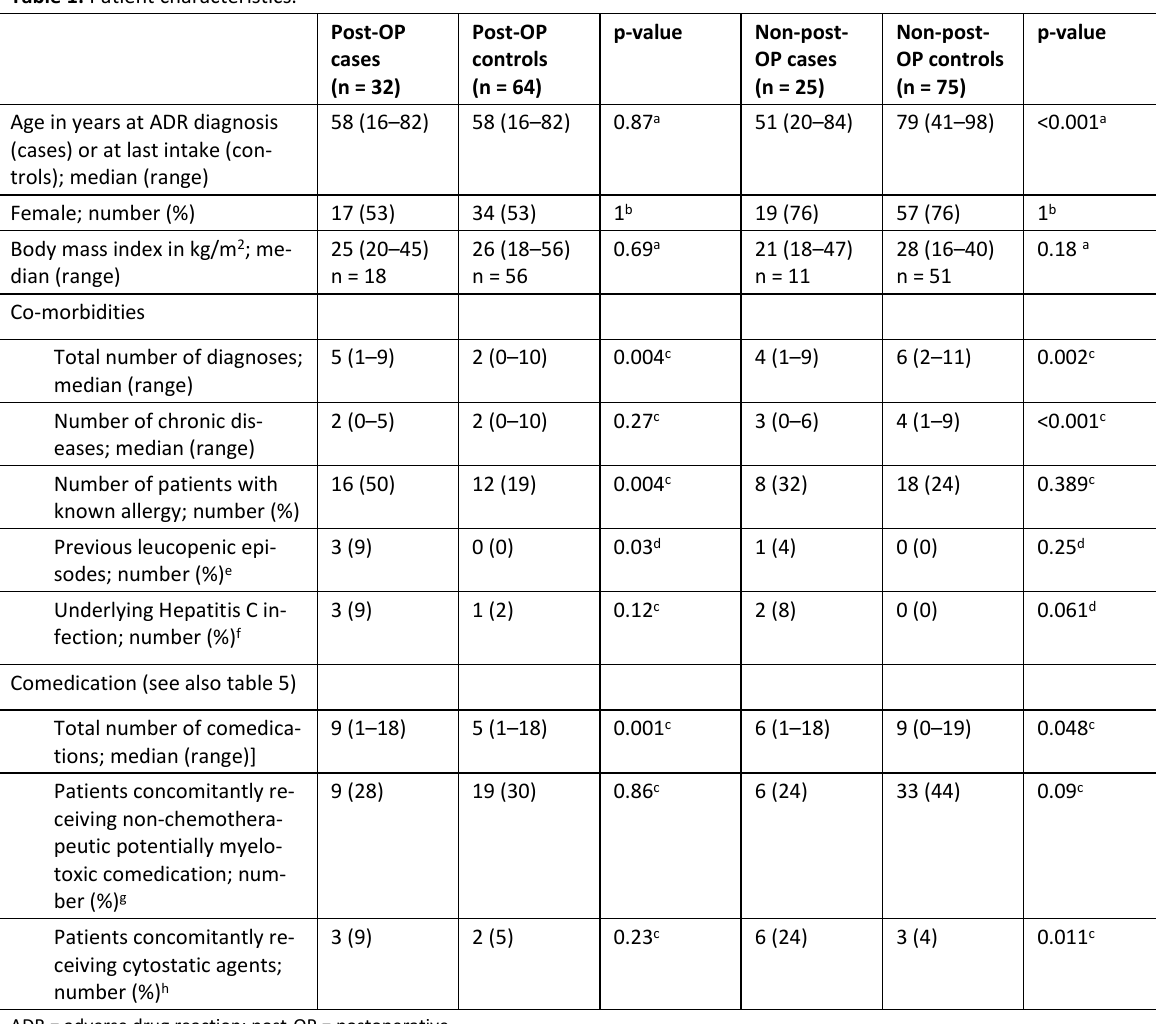
Table 1: Patient